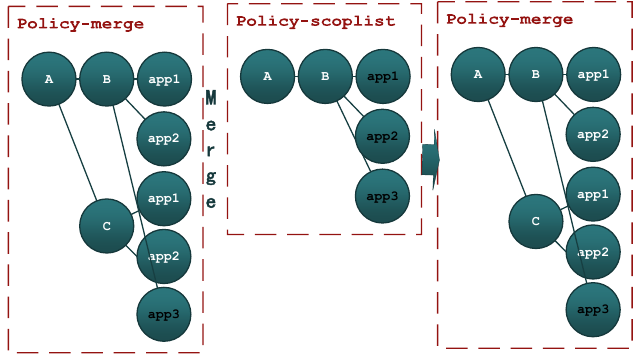
Figure 5. Tree mergers of config in the scope